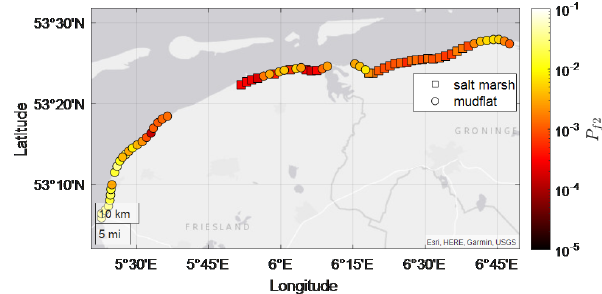
Figure 16. Influence of raised bed levels due to salt marshes on the spatial variation in the probability of dike failure by wave overtopping for Scenario 2: SS + IG waves ( P f Dutch Wadden Sea area for dikes with identical crest heights ( z c = 6m + NAP) and dike slopes (cot (α) =